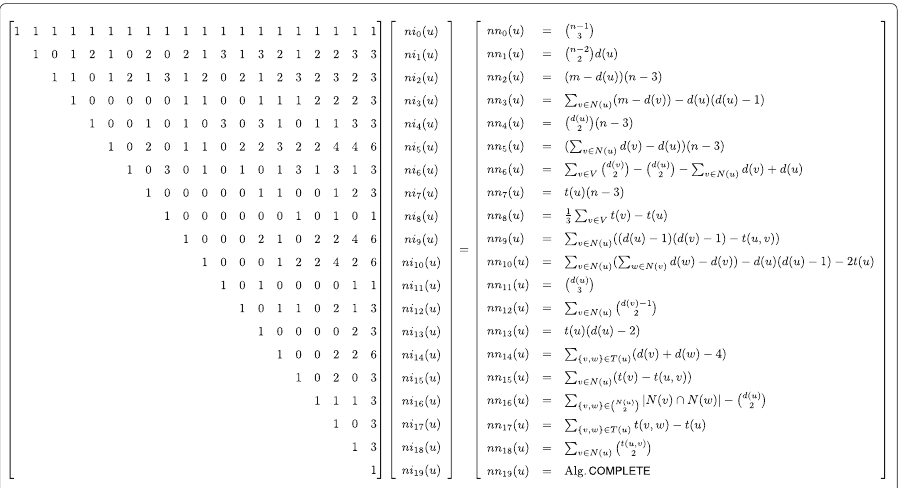
Fig. 4 System of equations for orbit-aware quad census on a node level. ni refers to induced and nn to non-induced